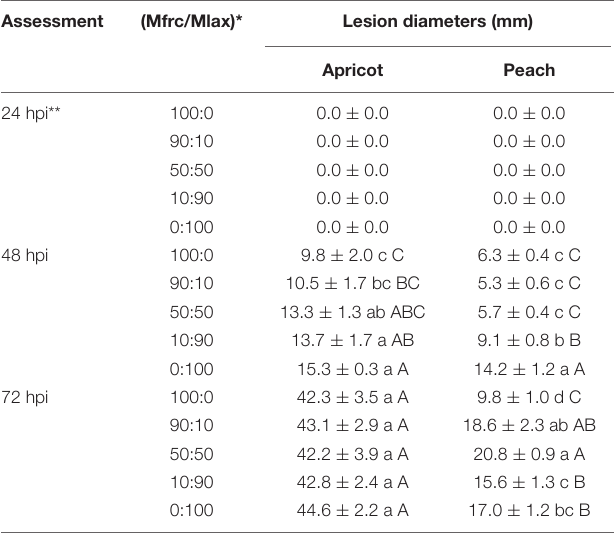
TABLE 2 | Lesion diameters on apricot and peach fruits artificially inoculated with different M. fructicola and M. laxa conidial suspension ratios.